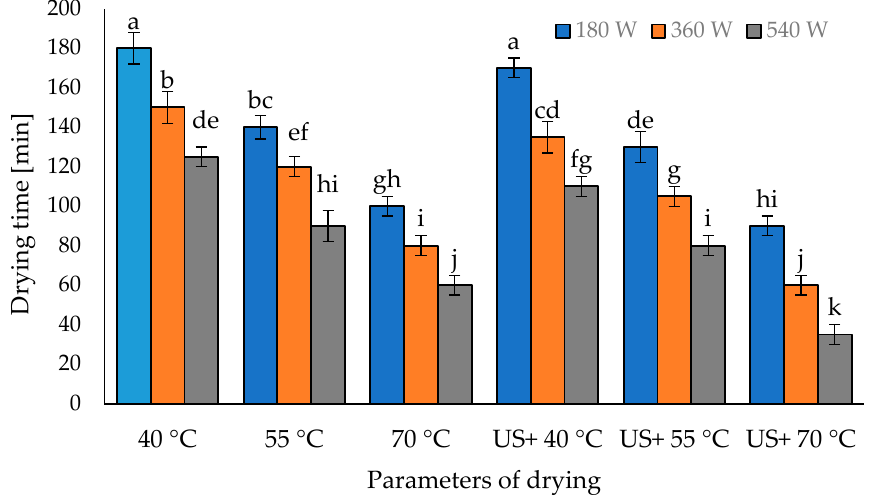
Figure 1. Drying time during different drying schemes. Data followed by different letters (a–k) in each column are significantly different at p < 0.01. Columns with the same letters are not significantly different.